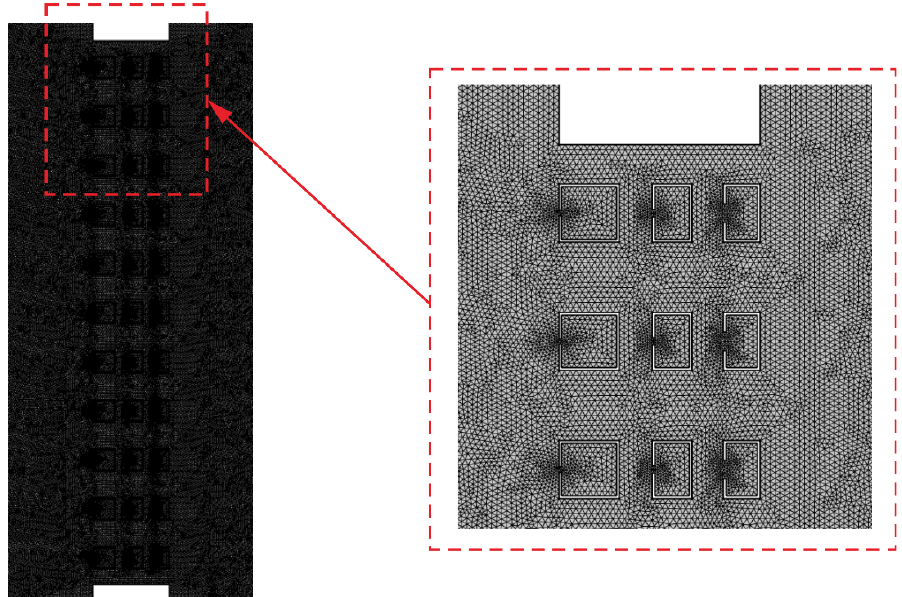
Figure 3. Boundary conditions applied in the 2D numerical model. Table 3. Parameters of the grid system in simulations.